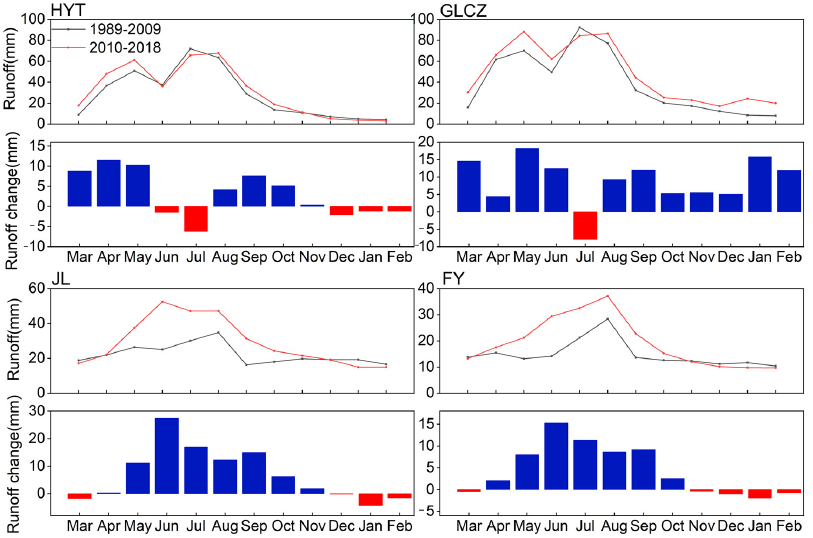
Figure 5. Intra-annual runoff distribution of the baseline period and disturbed period.